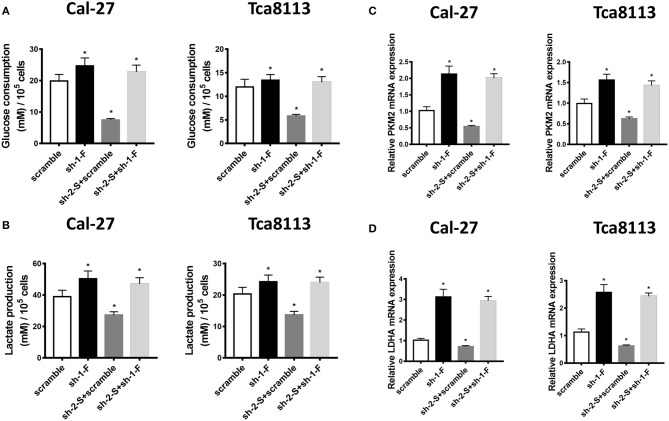
FoxO1 knockdown promotes aerobic glycolysis in OSCC cells. (A) Glucose consumption assay was used to detect the glucose consumption in Cal-27 and Tca8113 cells transfected with scramble, sh-1-FoxO1, sh-2-STAT3/scramble, or sh-2-STAT3/sh-1-FoxO1. The data showed that down-regulation of FoxO1, or both FoxO1 and STAT3 led to higher glucose consumption in Cal-27 and Tca8113 cells. (B) Lactate production assay was used to detect the lactate production in Cal-27 and Tca8113 cells transfected with scramble, sh-1-FoxO1, sh-2-STAT3/scramble, or sh-2-STAT3/sh-1-FoxO1. The data showed that down-regulation of FoxO1, or both FoxO1 and STAT3 led to higher lactate production in Cal-27 and Tca8113 cells. (C) PKM2 mRNA levels in Cal-27 and Tca8113 cells transfected with scramble, sh-1-FoxO1, sh-2-STAT3/scramble, or sh-2-STAT3/sh-1-FoxO1 were examined by qRT-PCR. (D) LDHA mRNA levels in Cal-27 and Tca8113 cells transfected with scramble, sh-1-FoxO1, sh-2-STAT3/scramble, or sh-2-STAT3/sh-1-FoxO1 were examined by qRT-PCR. Each assay was carried out in triplicate. Results were shown as means ± SD. *P < 0.05.